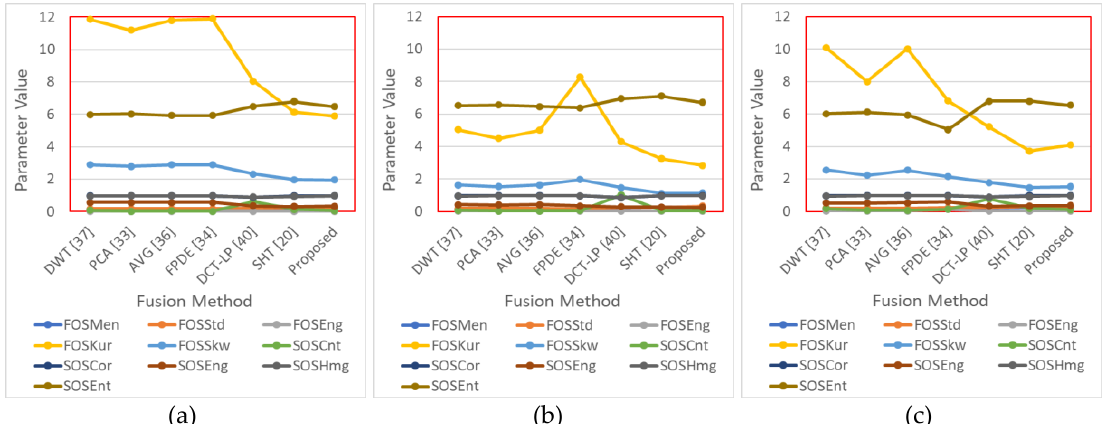
Figure 7. Analysis of multiband fusion-based first- and second-order textural features of scenes: ( a ) liquid, ( b ) food and ( c ) leaf.